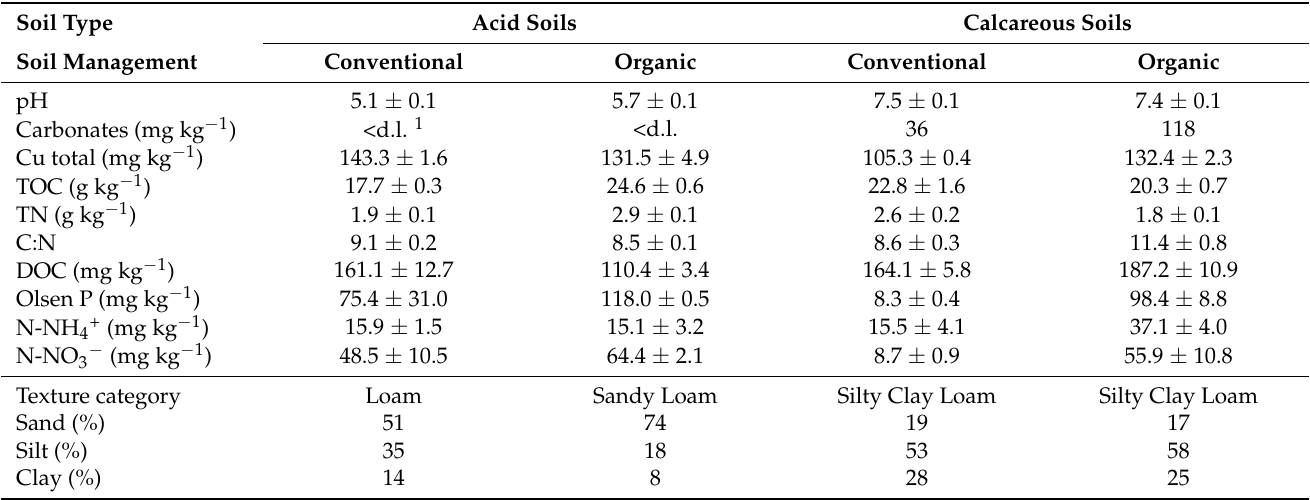
Table 1. Main physicochemical properties of